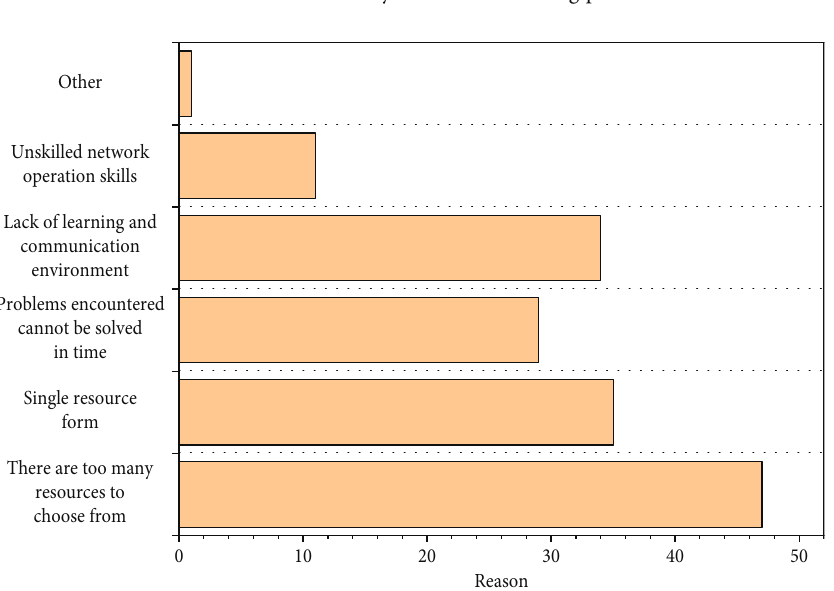
Figure 4: Survey of network teaching platform